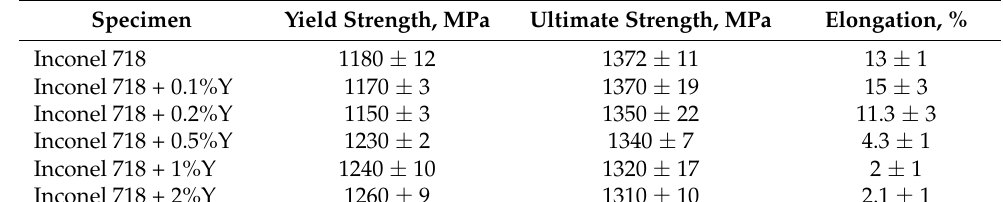
Table 3. Tensile mechanical properties of the samples. Specimen